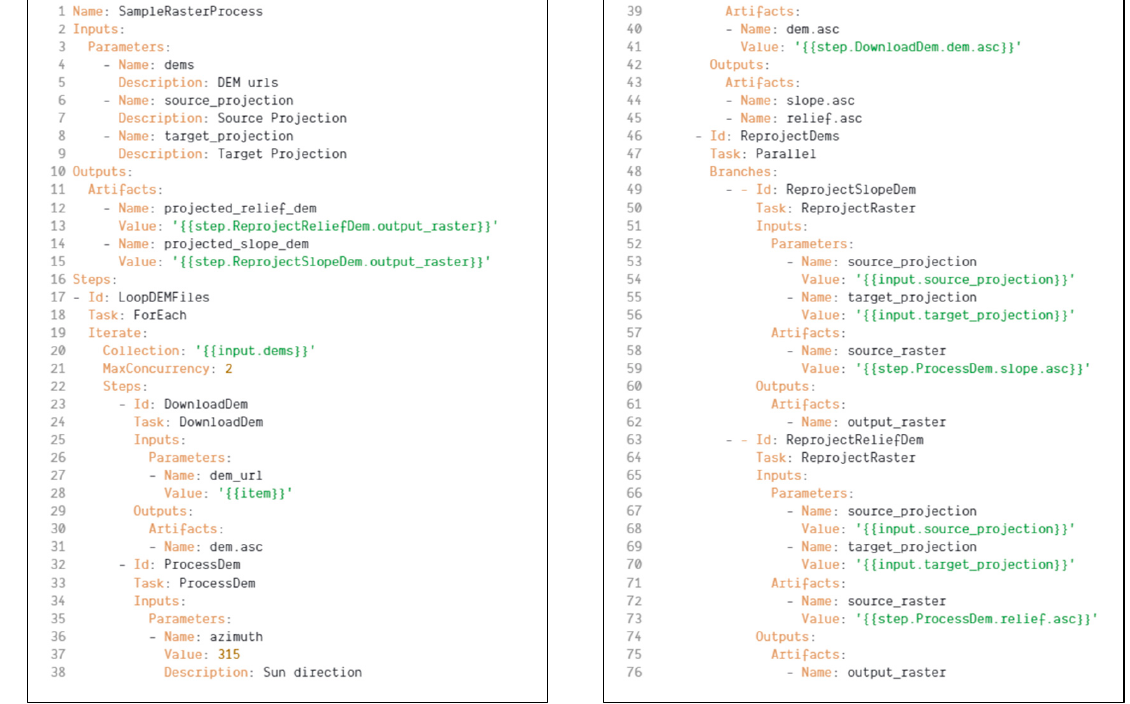
Figure 13. A sample workflow definition in the proposed workflow definition model.